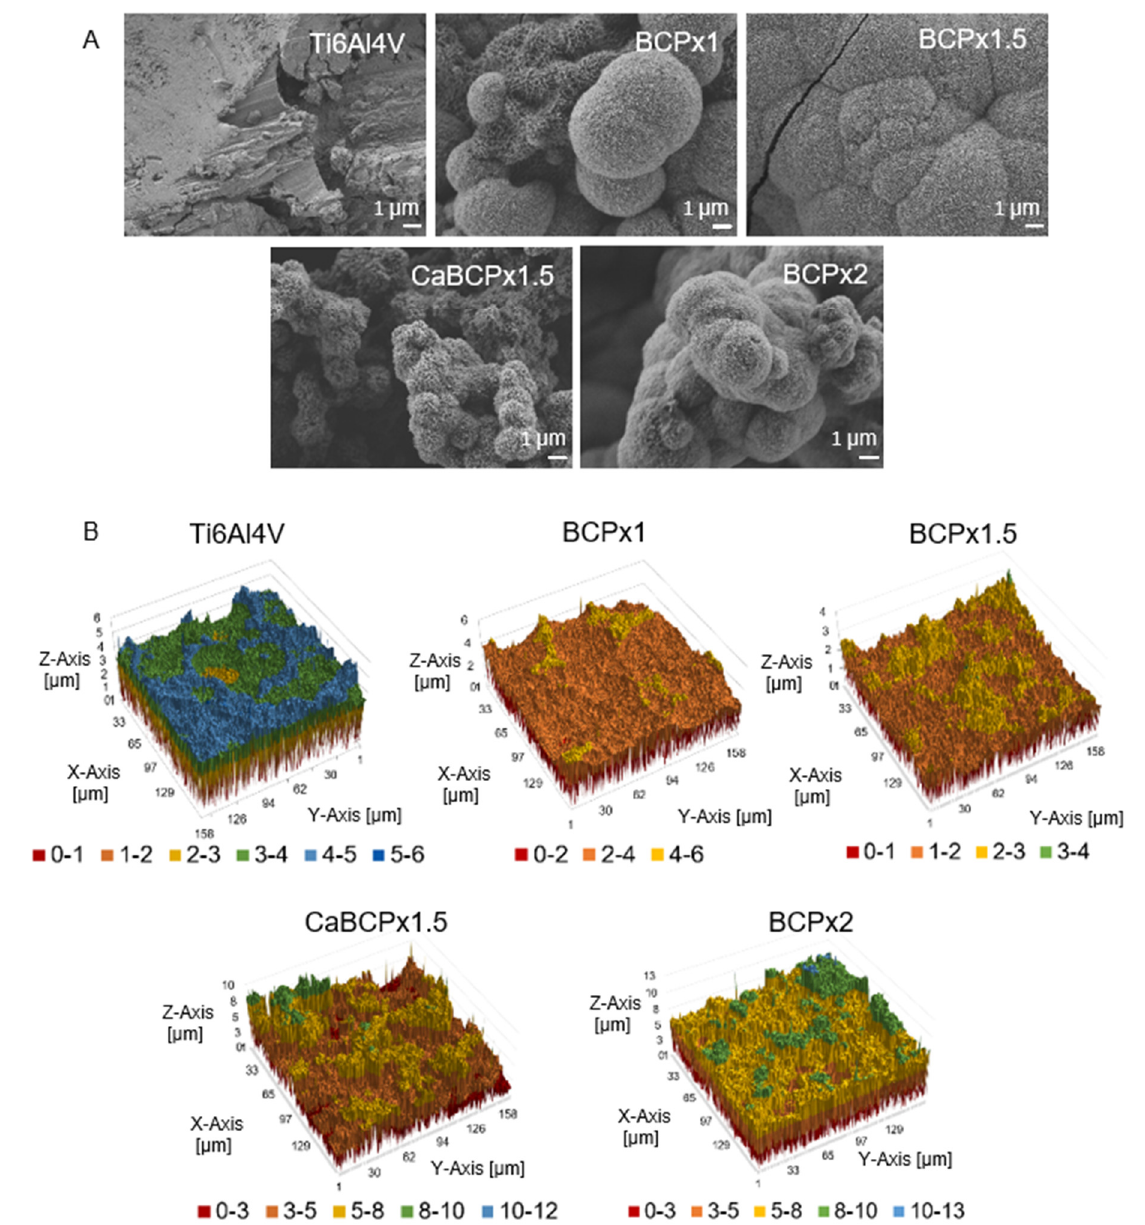
Figure 1. Analysis of biomimetic coatings precipitated on variable chemically pre-treated Ti6Al4V substrates after exposure to BCPx1, BCPx1.5, and BCPx2 for 14 days. ( A ) SEM analysis, Scale: 1 µm (overview images in Supplementary Materials Figure S1). ( B ) Laserprofilometry scans of the different surfaces.